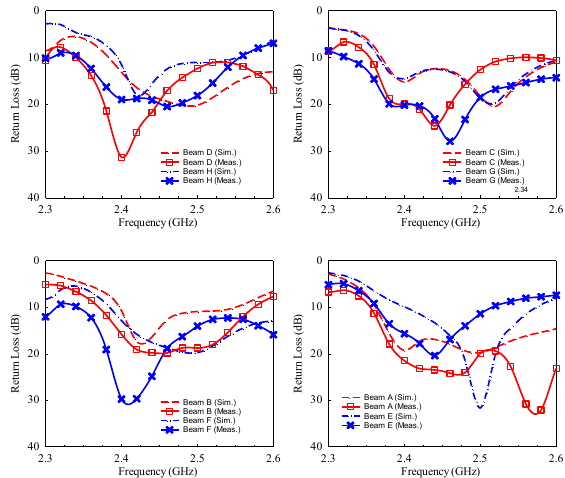
Figure 15: Simulated and measured S-parameters of a few radiation beams.